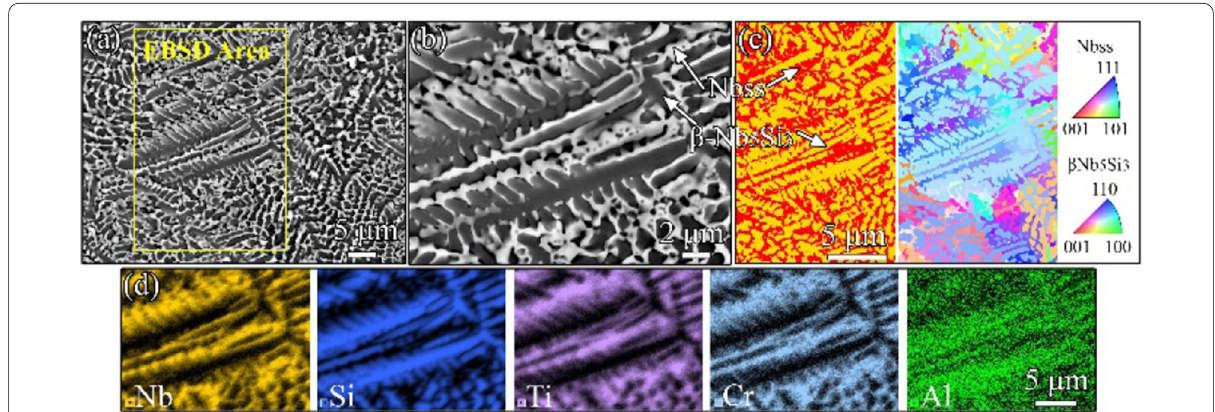
Figure 4 Microstructures and elemental distributions of the hypereutectic Nb-Si based alloy via EBSM: ( a ) BSE image; ( b ) Zoom-in BSE image; ( c ) EBSD phase and inverse pole figure (IPF) maps in the selected area in ( a ); ( d ) EDS mappings of ( b )